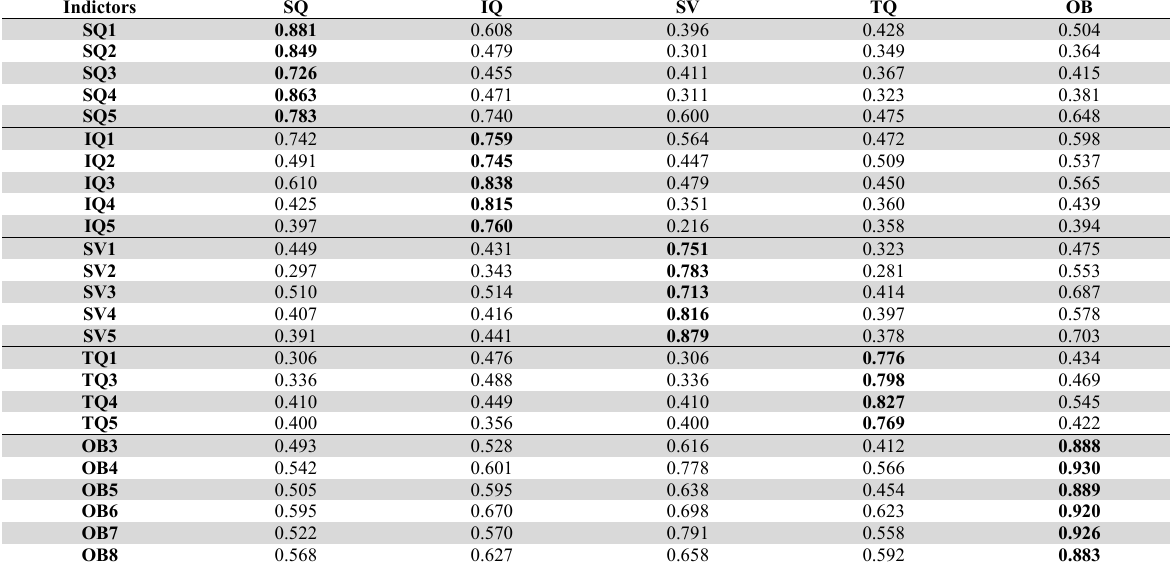
Results of discriminant validity